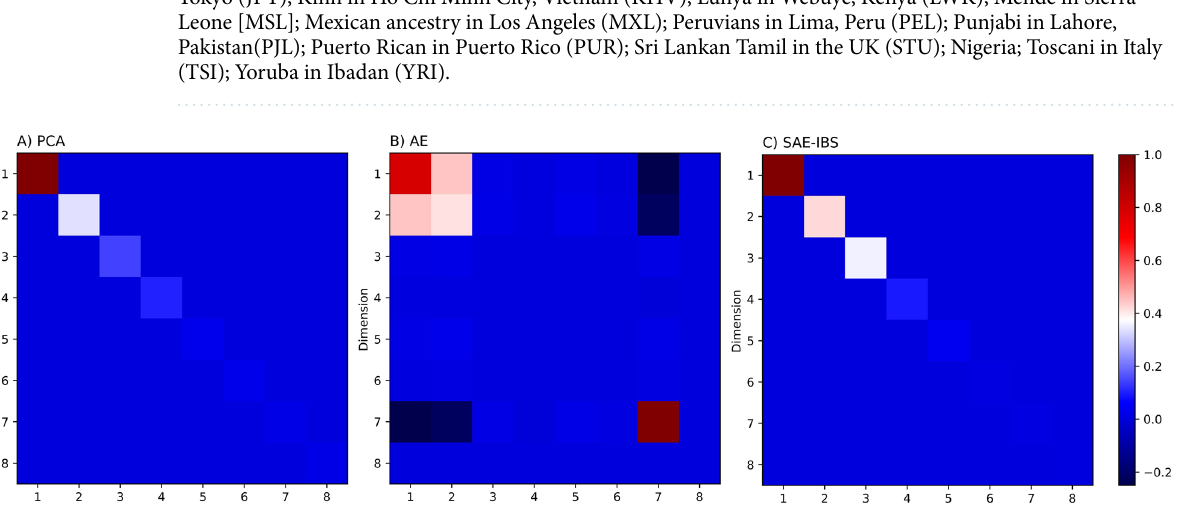
Figure 3. Covariance matrix of the ancestry scores for the 8-dimensional spaces constructed by ( A ) PCA, ( B ) AE, ( C ) SAE-IBS. The elements on the diagonal represent the amount of variance explained by each of the dimensions. The off-diagonal elements show the correlation between the axes along corresponding dimensions. Blue blocks indicate low (co)variance and red blocks indicate high